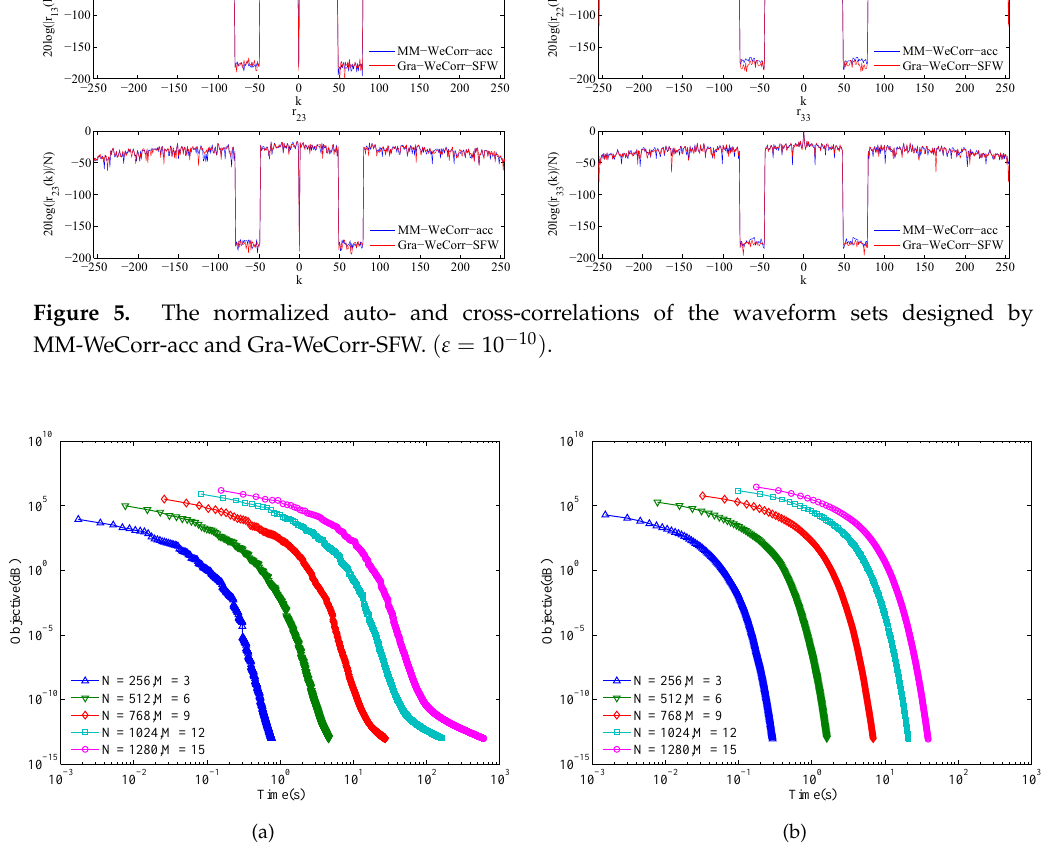
Figure 6. Evolution of the objective function with respect to the running time: ( a ) MM-WeCorr-acc; ( b ) Gra-WeCorr-SFW ( ε = 10 − 13 )